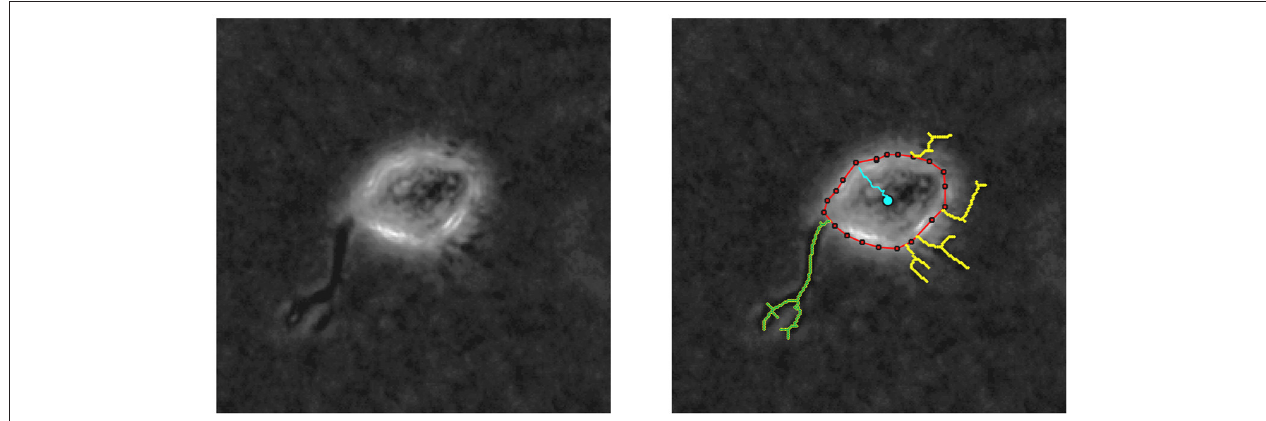
FIGURE 6 | (Left) Phase contrast example of a NHDF cell cultivated in a 2 mg/ml collagen gel, with 200x magnification (20x objective) acquired using multidimensional microscopy. (Right) Protrusion analysis performed by in-house Matlab algorithms; red line delimits cell body, yellow lines represent the protrusions, and blue line shows cell body displacement. In this case, the longest protrusion is the green one and the number of protrusions is